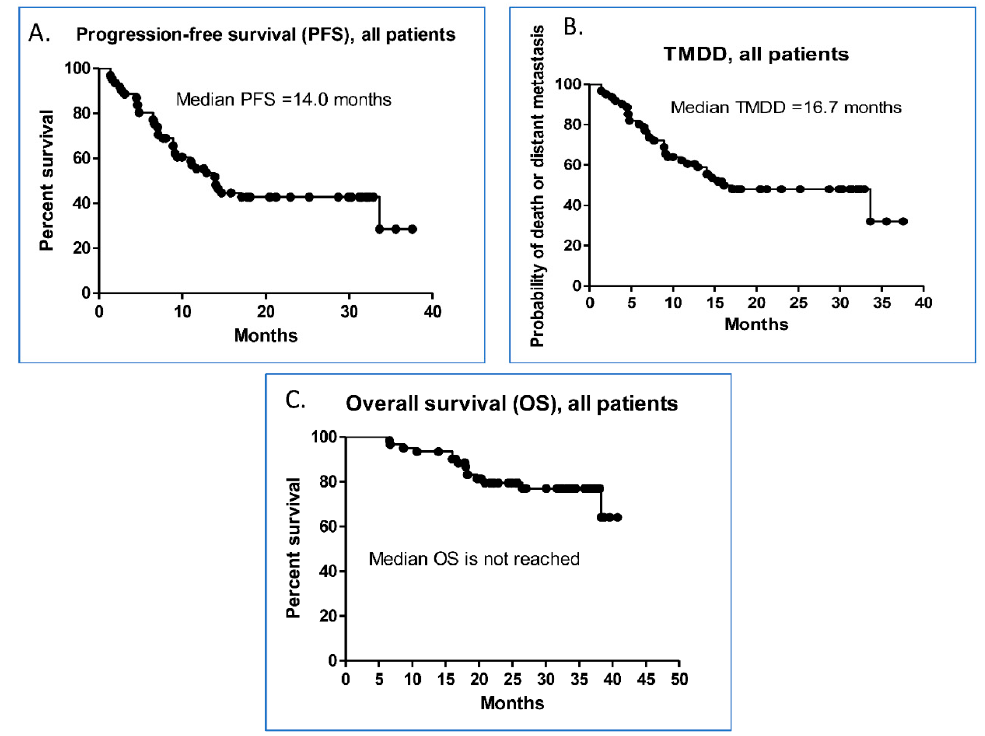
Figure 2. Kaplan–Meier survival curves of the ( A ) PFS, ( B ) TMDD, and ( C ) OS of all study patients. Table 2. Cox regression analysis of predictive factors associated with the PFS of durvalumab therapy.